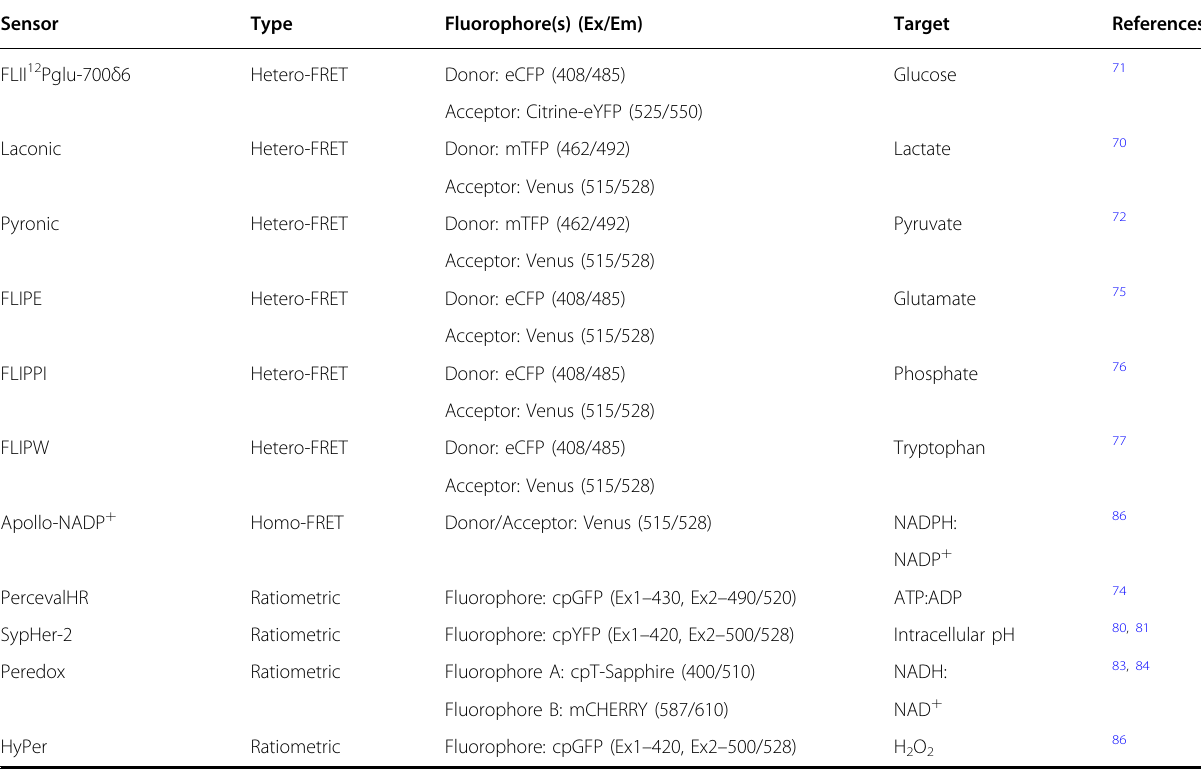
Table 2 Genetically encoded fl uorescent biosensors